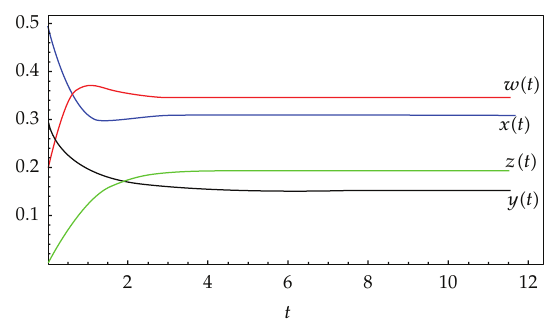
Figure 3: β 10 (cid:3) 0 . 1, β 20 (cid:3) 0 . 6, λ 0 (cid:3) 0 . 01, α 10 (cid:3) 0 . 1, γ 0 (cid:3) 0 . 01, θ (cid:3) 0 . 5, μ (cid:3) 0 . 1, and R 0 (cid:3) 3 . 23.